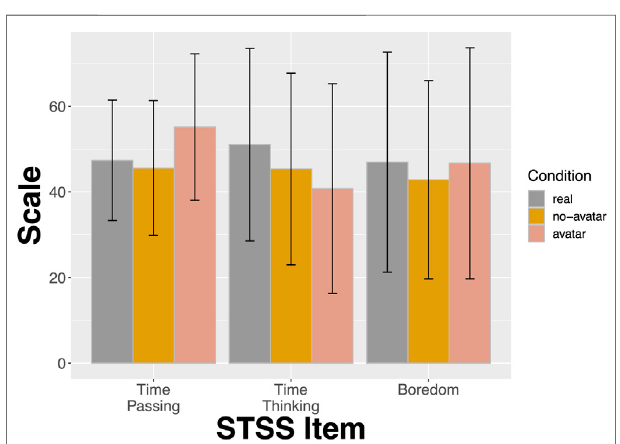
FIGURE 7 | Score on the STSS items “ Time Passing, ” “ Time Thinking ” and “ Boredom ” in the no-avatar and avatar condition, with standard deviation